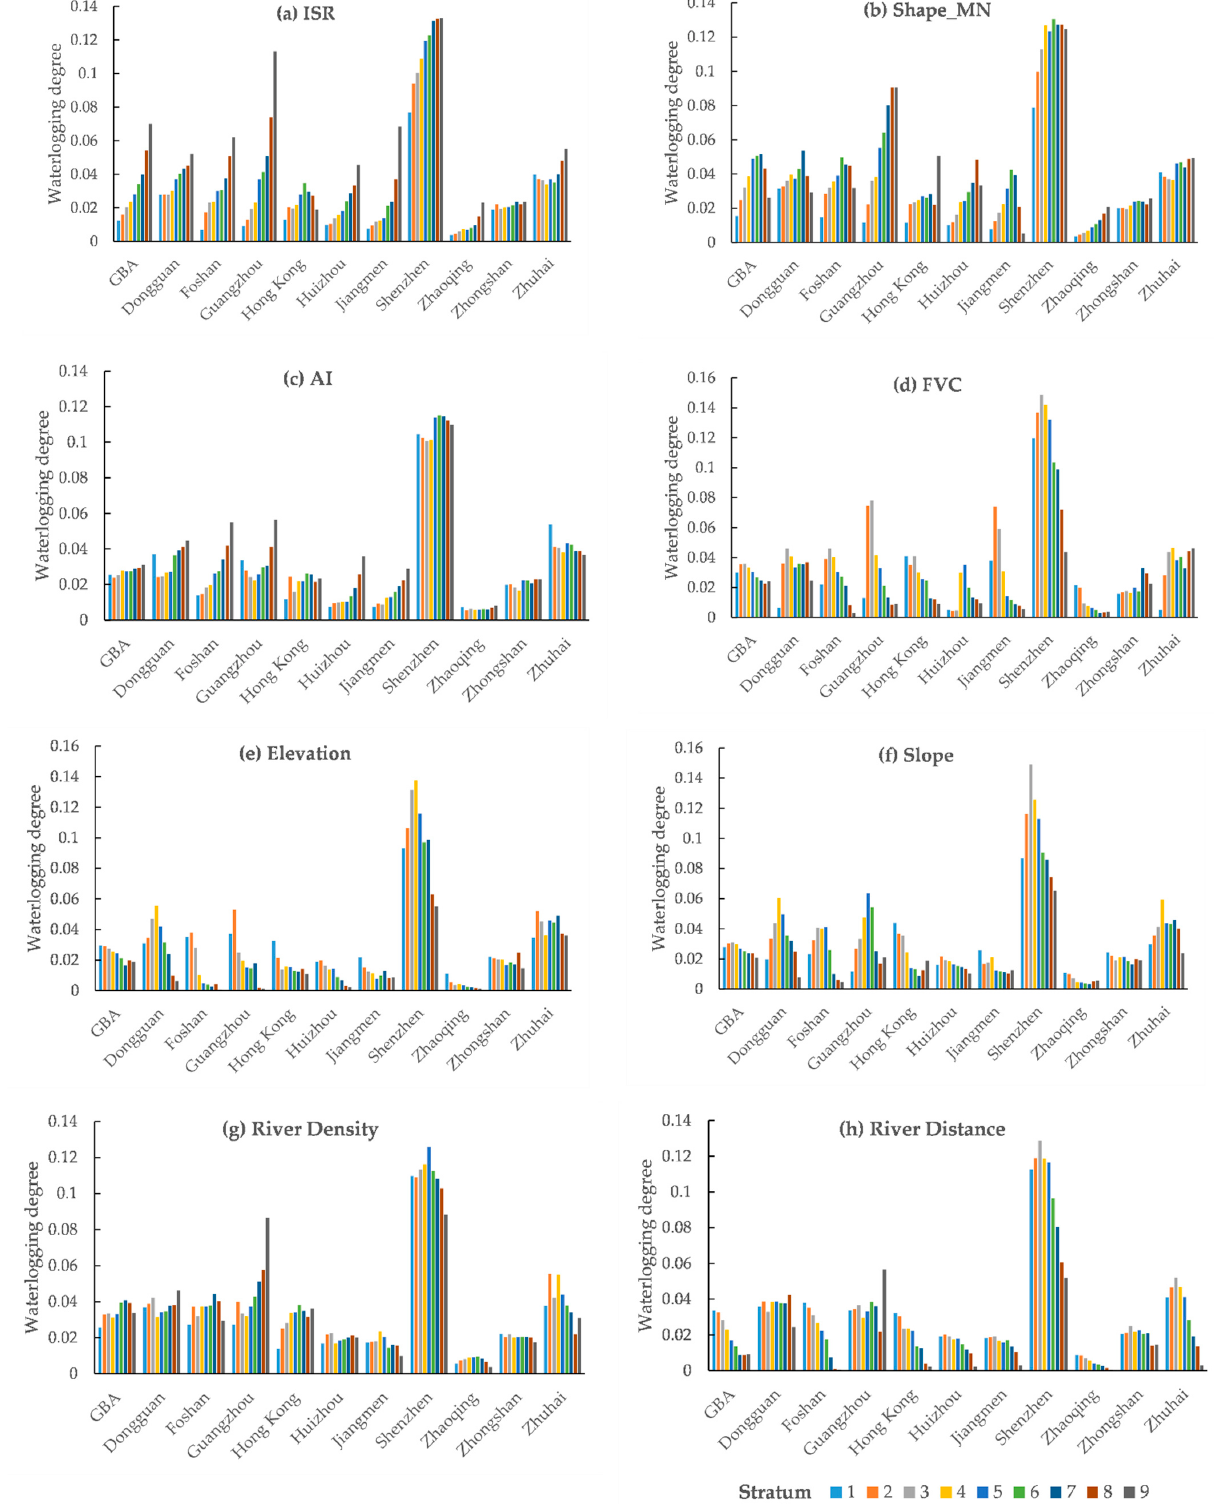
Figure 5. Risk detection of the driving factors of rainstorm waterlogging in the whole GBA and in local cities